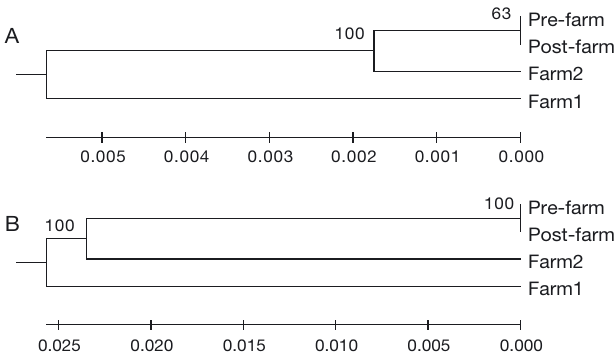
Fig. 5. Fixation index ( F ST ) values from pairwise tests of Pre- farm and Post-farm Atlantic cod samples, where Post-farm individuals have been replaced by 5, 7, 10, and 20% Farm1 and Farm2 individuals, respectively. Levels of probability detection at 95%, 80% and 50% are drawn at F ST levels 0.0014, 0.0009 and 0.0006,